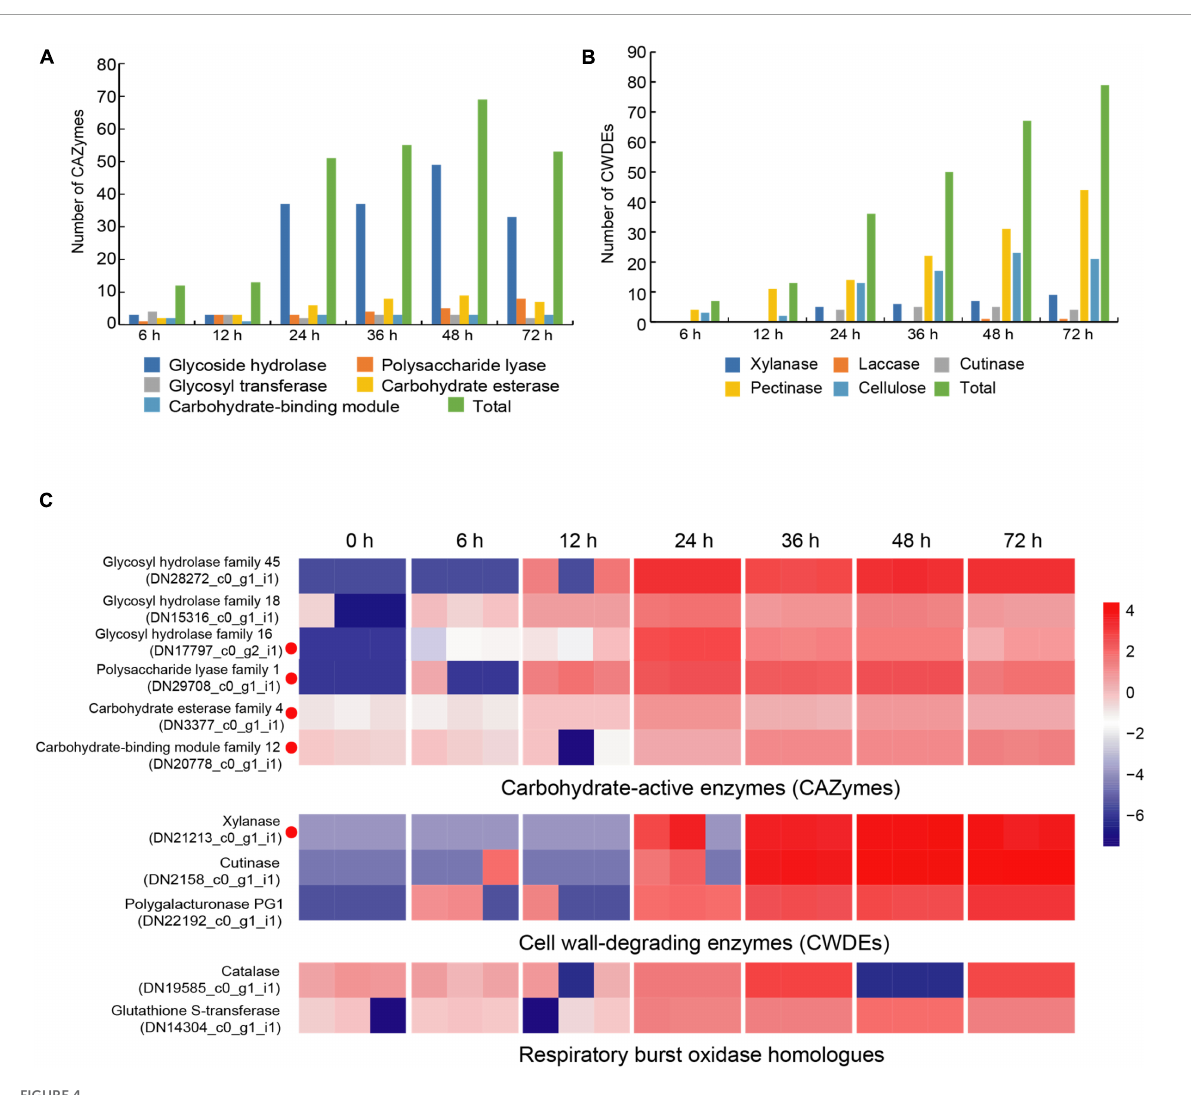
FIGURE4 Changes of different enzyme genes during various infection stages. (A) The number of CAZymes at different infection stage. (B) The number of CWDEs at different infection stages. (C) Expression patterns of candidate genes on CAZymes ( glycosy hydrolase family 45 , glycosy hydrolase family 18 , glycosy hydrolase family 16 , polysaccharide lysae family 1 , carbohydrate esterase family 4 , carbohydrate-binding module family 12 ), CWDEs ( xylanase , cutinase , polygalacturonase PG1 ) and respiratory burst oxidase homologs ( catalase , glutathione S-transferase ). The heatmap describes the enzyme gene expression at different stages (RPKM in log10-scale). The red circles next to the heatmap were candidate genes tested by